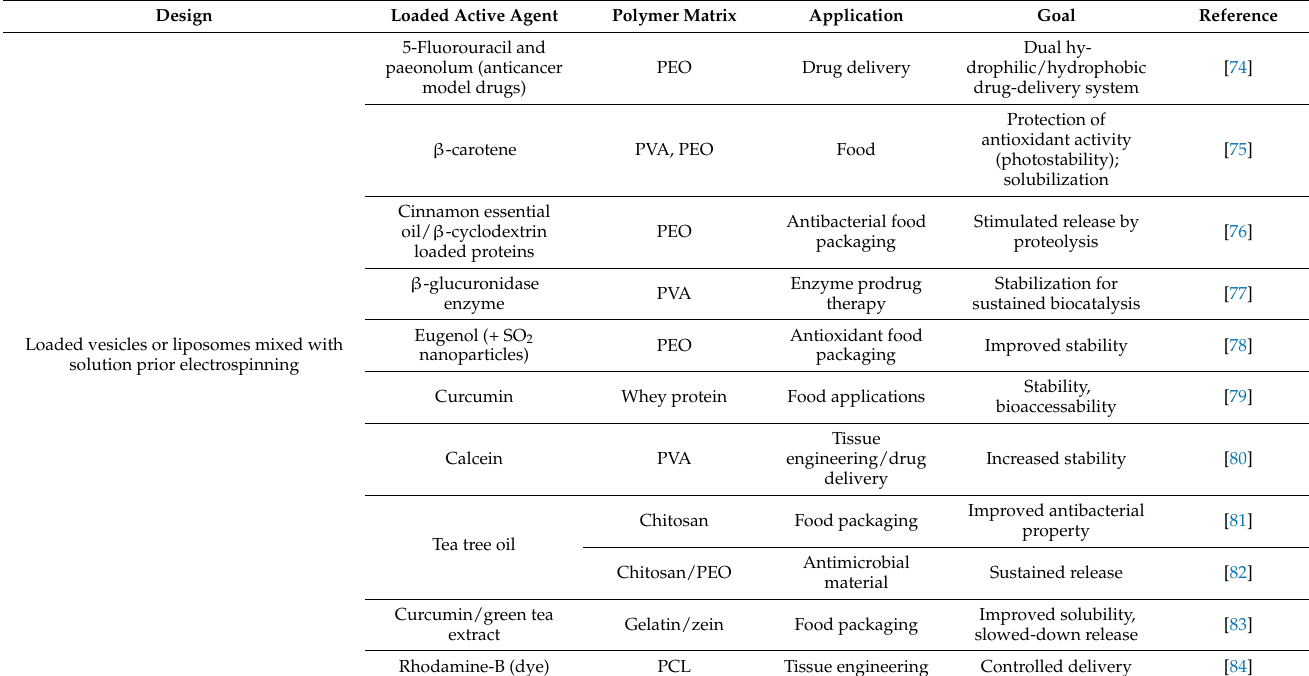
Table 2. Recent works reporting different strategies for the incorporation of loaded vesicles/liposomes to electrospun nanofibers or electrosprayed nanoparticles for diverse goals and application areas. Sorted by date